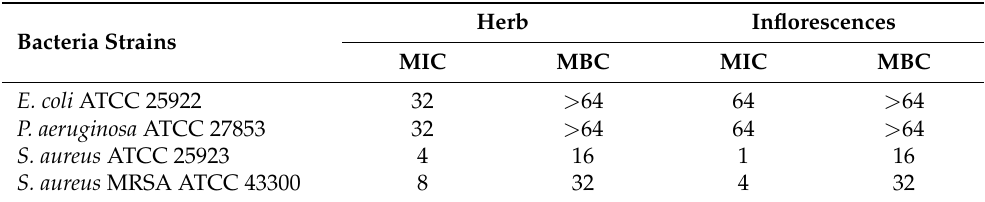
Table 6. MIC and MBC values of essential oils (mg × mL − 1